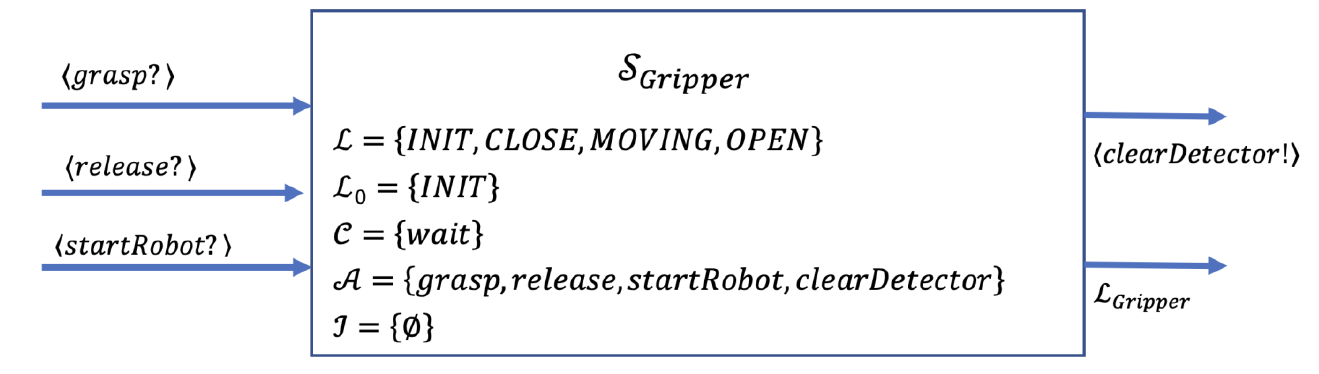
Figure 9. Block diagram of the gripper module.